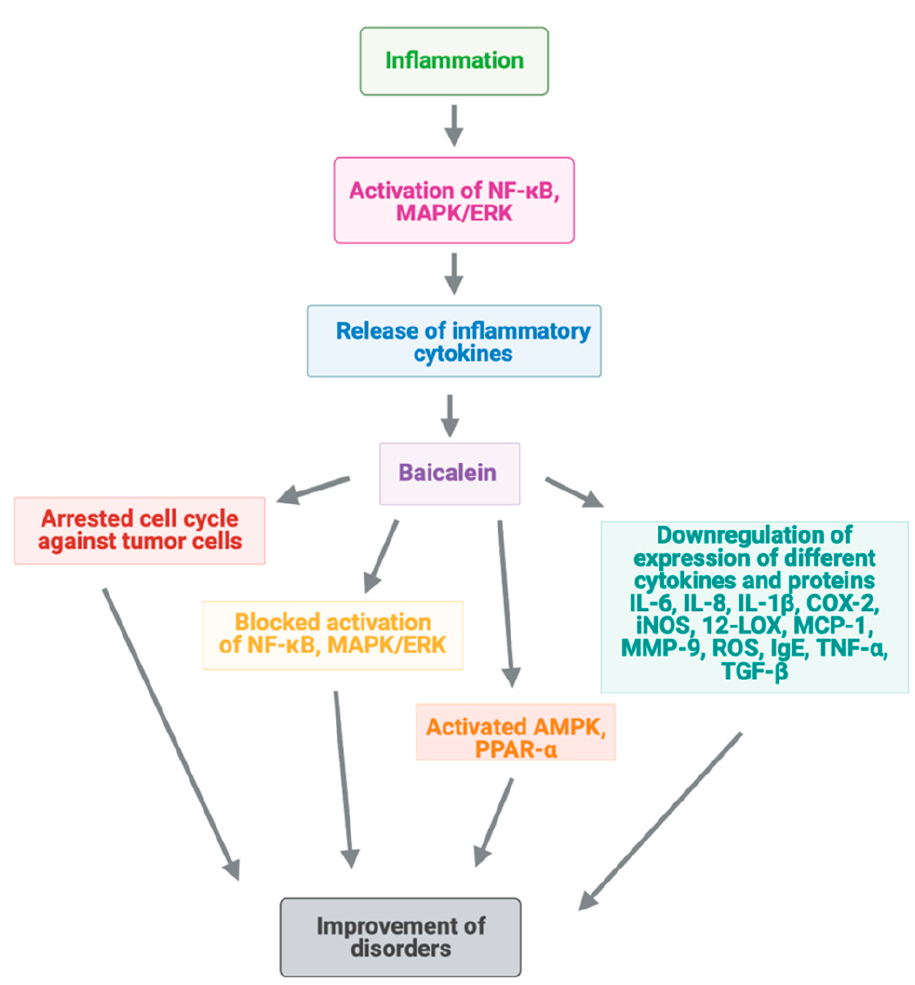
Figure 2. Mechanisms of baicalein action for amendment of inflammation via different signaling pathways.